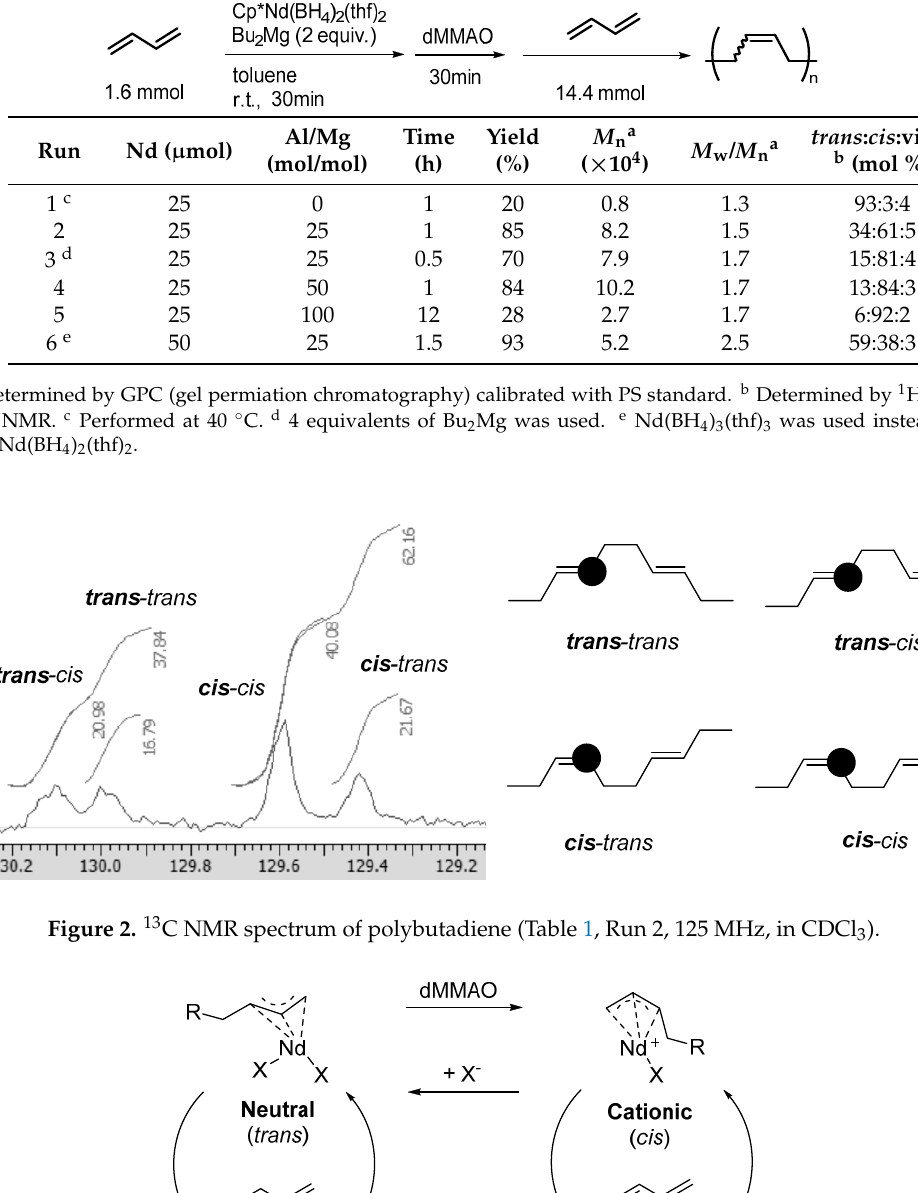
Figure 3. Plausible mechanism of stereospecificity change of butadiene polymerization at low dMMAO concentration.